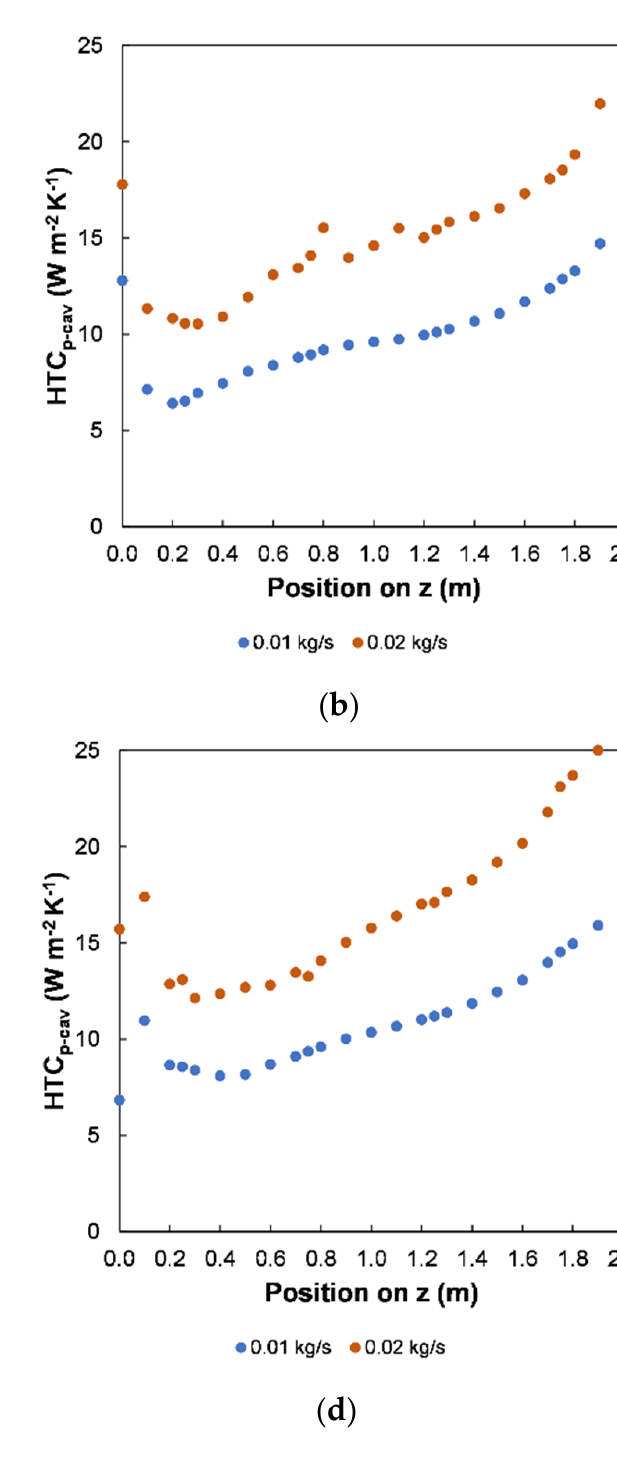
Figure 11. Flat-plate receiver heat transfer coefficients (HTC p-cav ). ( a ) Down–Down; ( b ) Down–Up; ( c ) Up–Up; ( d ) Up–Down. In configurations where the air enters from the top ((c) and (d)), there is a high HTC p-cav at z = 0.1 m; nevertheless, all configurations have the maximum HTC p-cav in the region near the outlet. The above observations indicate that the HTC p-cav maximums correspond to the presence of the eddies produced by the sudden expansion at the inlet. While in the region near the outlet, there are also high HTC p-cav at z = 2.0 m in configuration (b), but in configurations (a), (c), and (d), it occurs around z = 1.8 m to z = 1.9 m. For